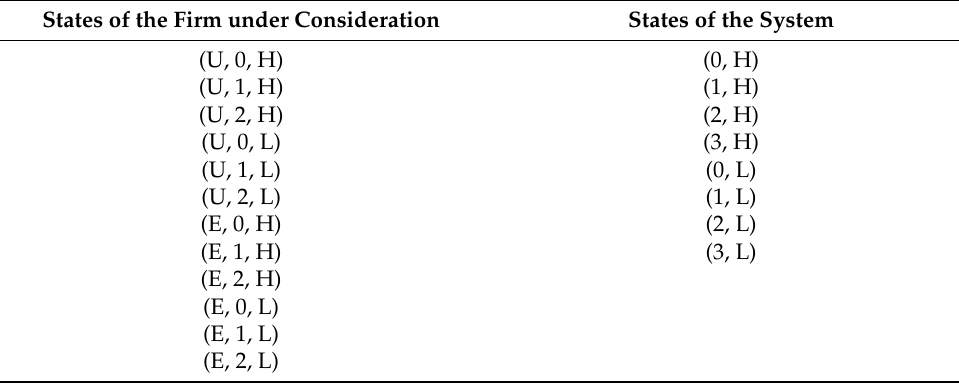
Table 3. States of the firm under consideration and the system with three active firms.